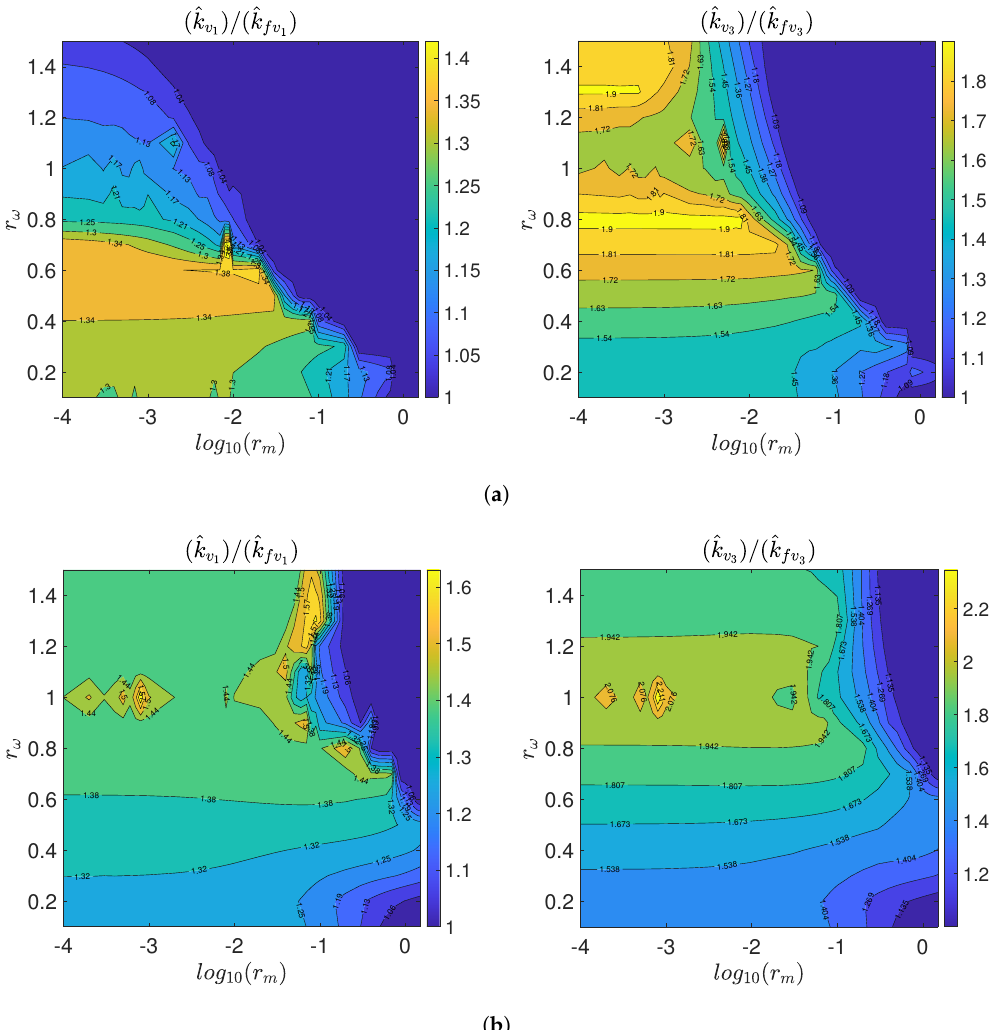
/ˆ k ˆ k /ˆ k v 3 fv 1 and fv 3 for: ( a ) a single disturbance force; and ( b ) for three disturbance 1